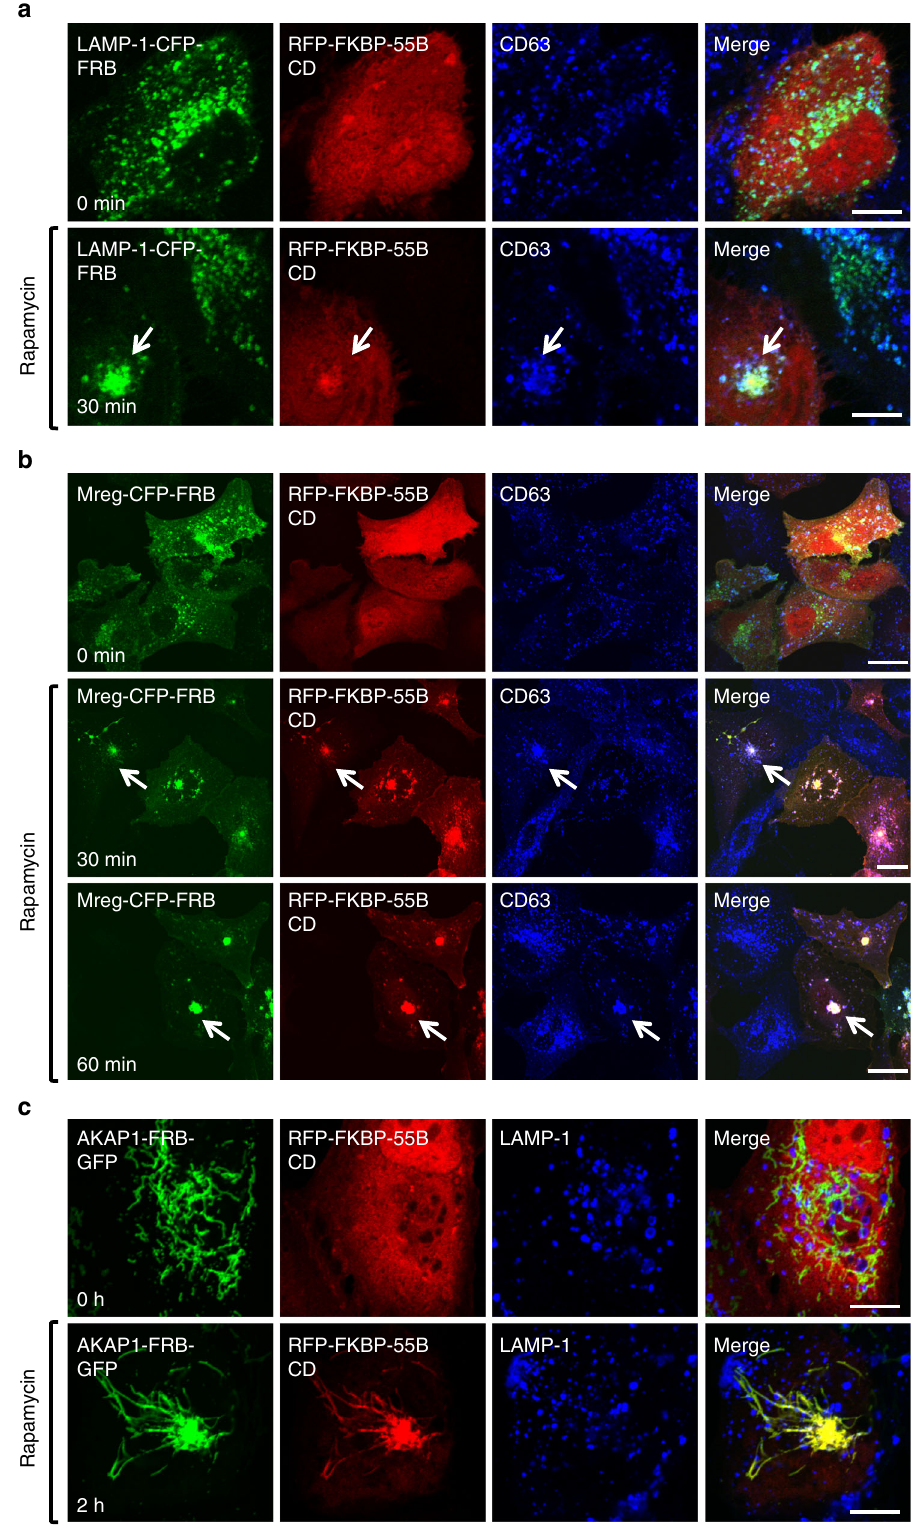
Fig. 3 Recruitment of TMEM55B CD initiates retrograde transport of tagged membranes towards the cell center. ARPE-19 cells transfected with a LAMP-1- CFP-FRB and RFP-FKBP-TMEM55B CD, b Melanoregulin (Mreg 1-42)-CFP-FRB and RFP-FKBP-TMEM55B CD, or c AKAP1-FRB-GFP and RFP-FKBP- TMEM55B CD. Cells were incubated in 200 nM Rapamycin for the indicated times. Cells were fi xed, permeabilized, and immunostained with antibodies against CD63 ( a , b ) or LAMP-1 ( c ). Arrows indicate TMEM55B CD-induced lysosomal clustering. Scale bars, 10 μ m ( a , c ) or 20 μ m ( b